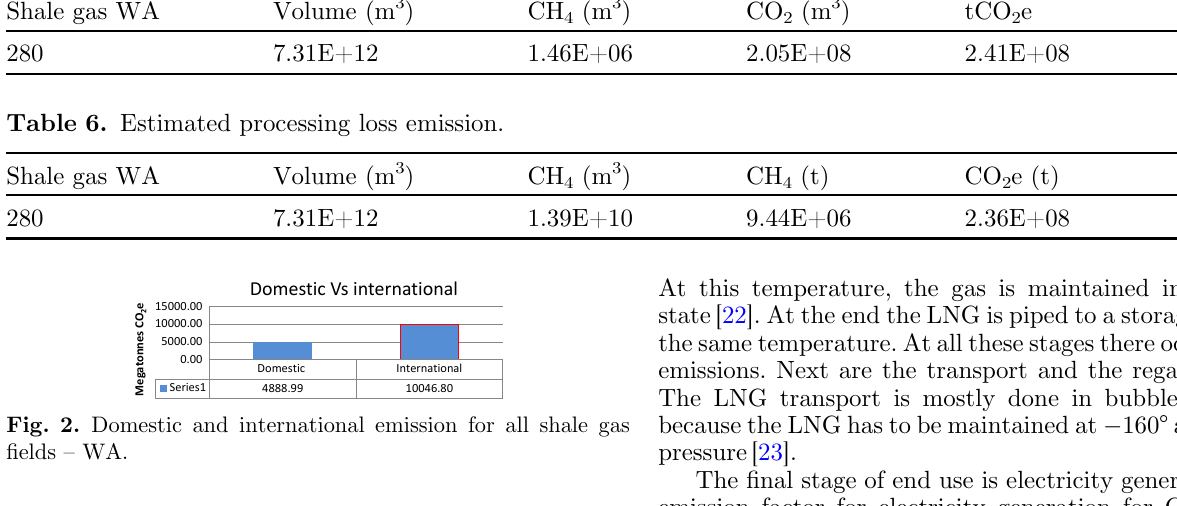
Table 5. Emission from fl aring from extraction of all the gas resources from WA. Shale gas WA